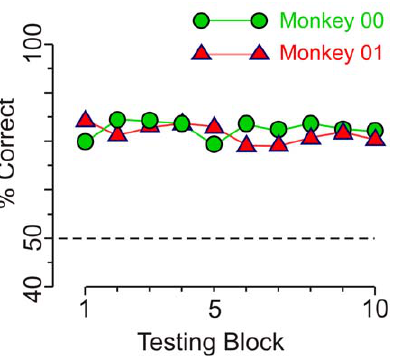
Figure 8. Performance over the course of testing in Experiment 2. The performance of the animals during the testing sessions is shown. Each data point is averaged from 120 trials from each animal (60 trials each of Main- and Control fragments), randomly interleaved with each other. Note that the performance is lower than the average response for Main fragments (Fig. 7A), because the responses were averaged across Main- and Control fragments. Similar results were obtained when the data were analyzed separately for Main-, Control- or IPControl fragments in this experiment and in Experiment 1 (3-way ANOVA, testing blocks x fragment number x fragment type; p , 0.05 for testing blocks).